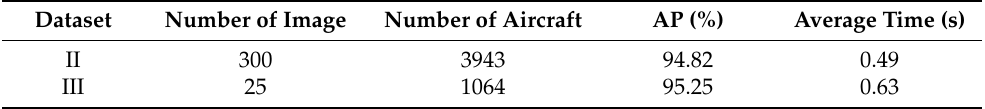
Table 3. Performance of the model on test datasets.